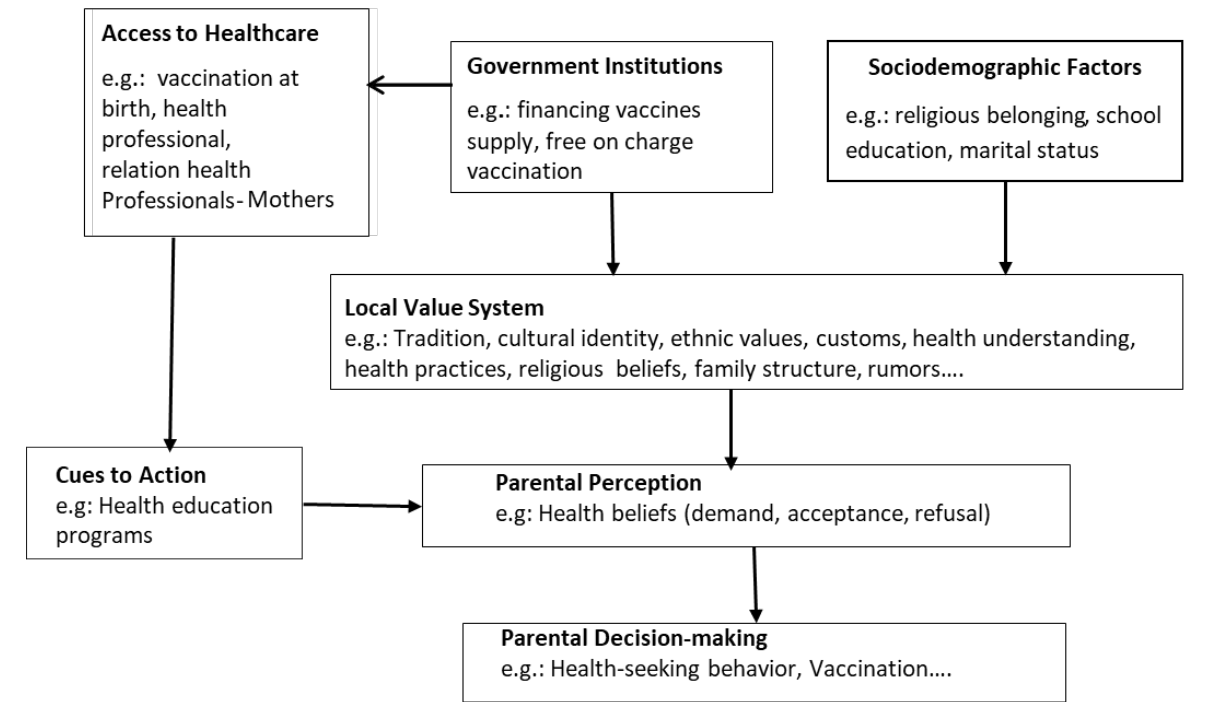
Figure 1. Proposed community-based conceptual framework of parental decision-making.